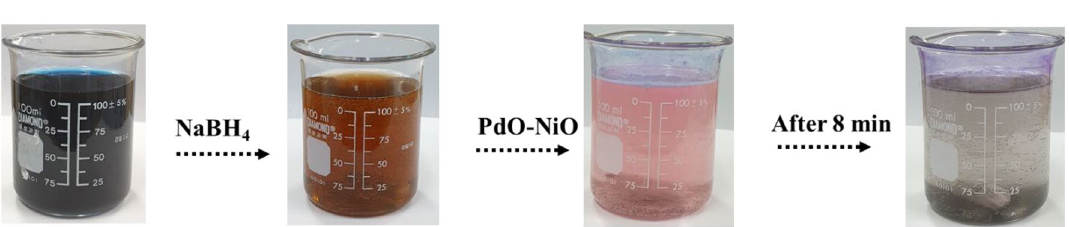
Figure 10. Reaction progress of an azo compounds mixture (4-NP, 2,4-DNP, 2,4,6-TNP, MB, RhB, MO) with PdO–NiO and NaBH